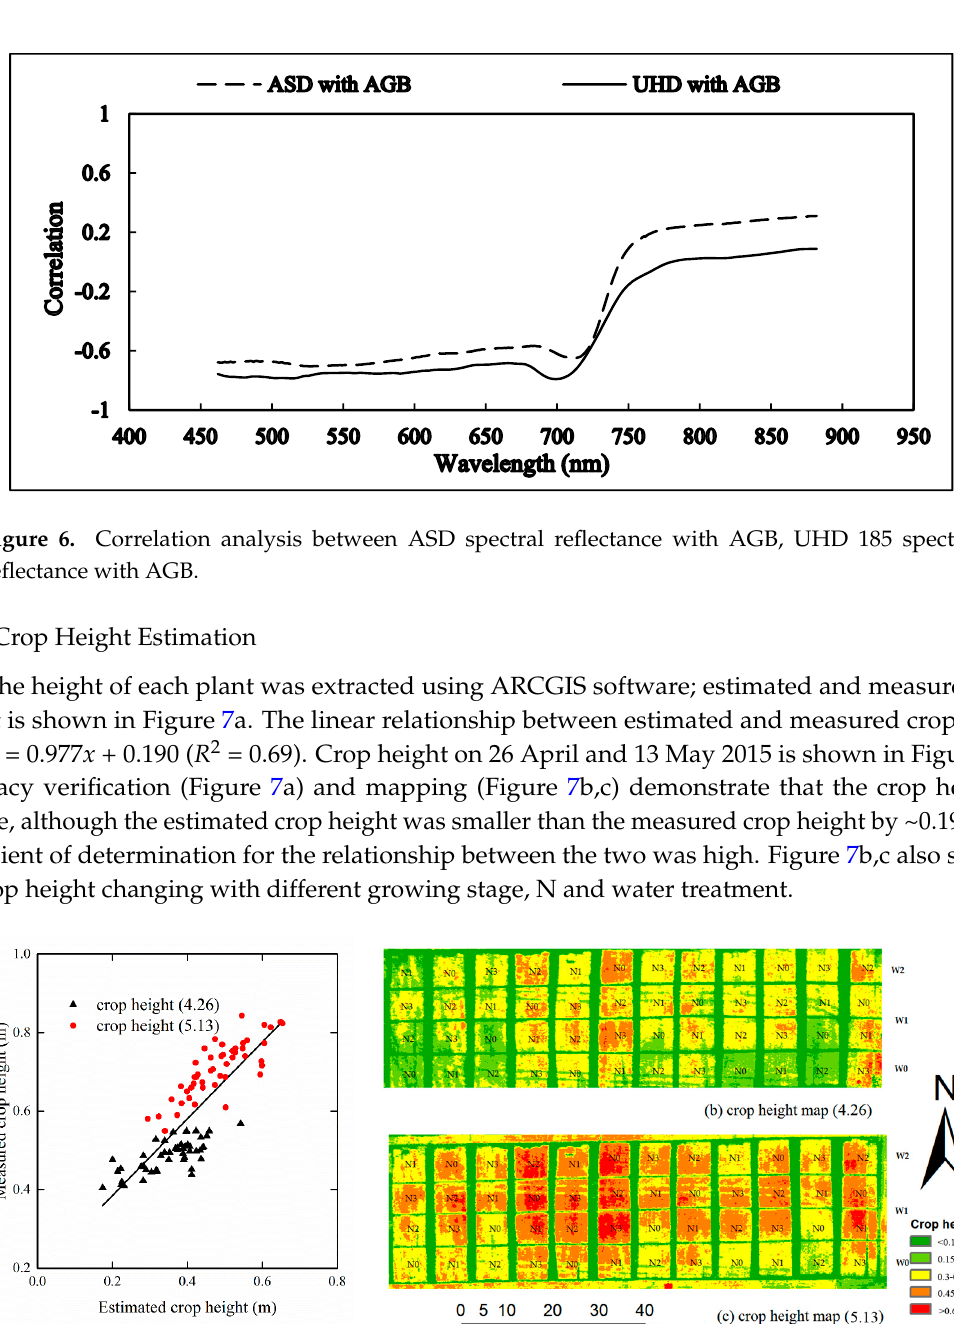
Table 2. Correlation coefficients (r) between AGB, specific bands and spectral vegetation indices (n = 96).